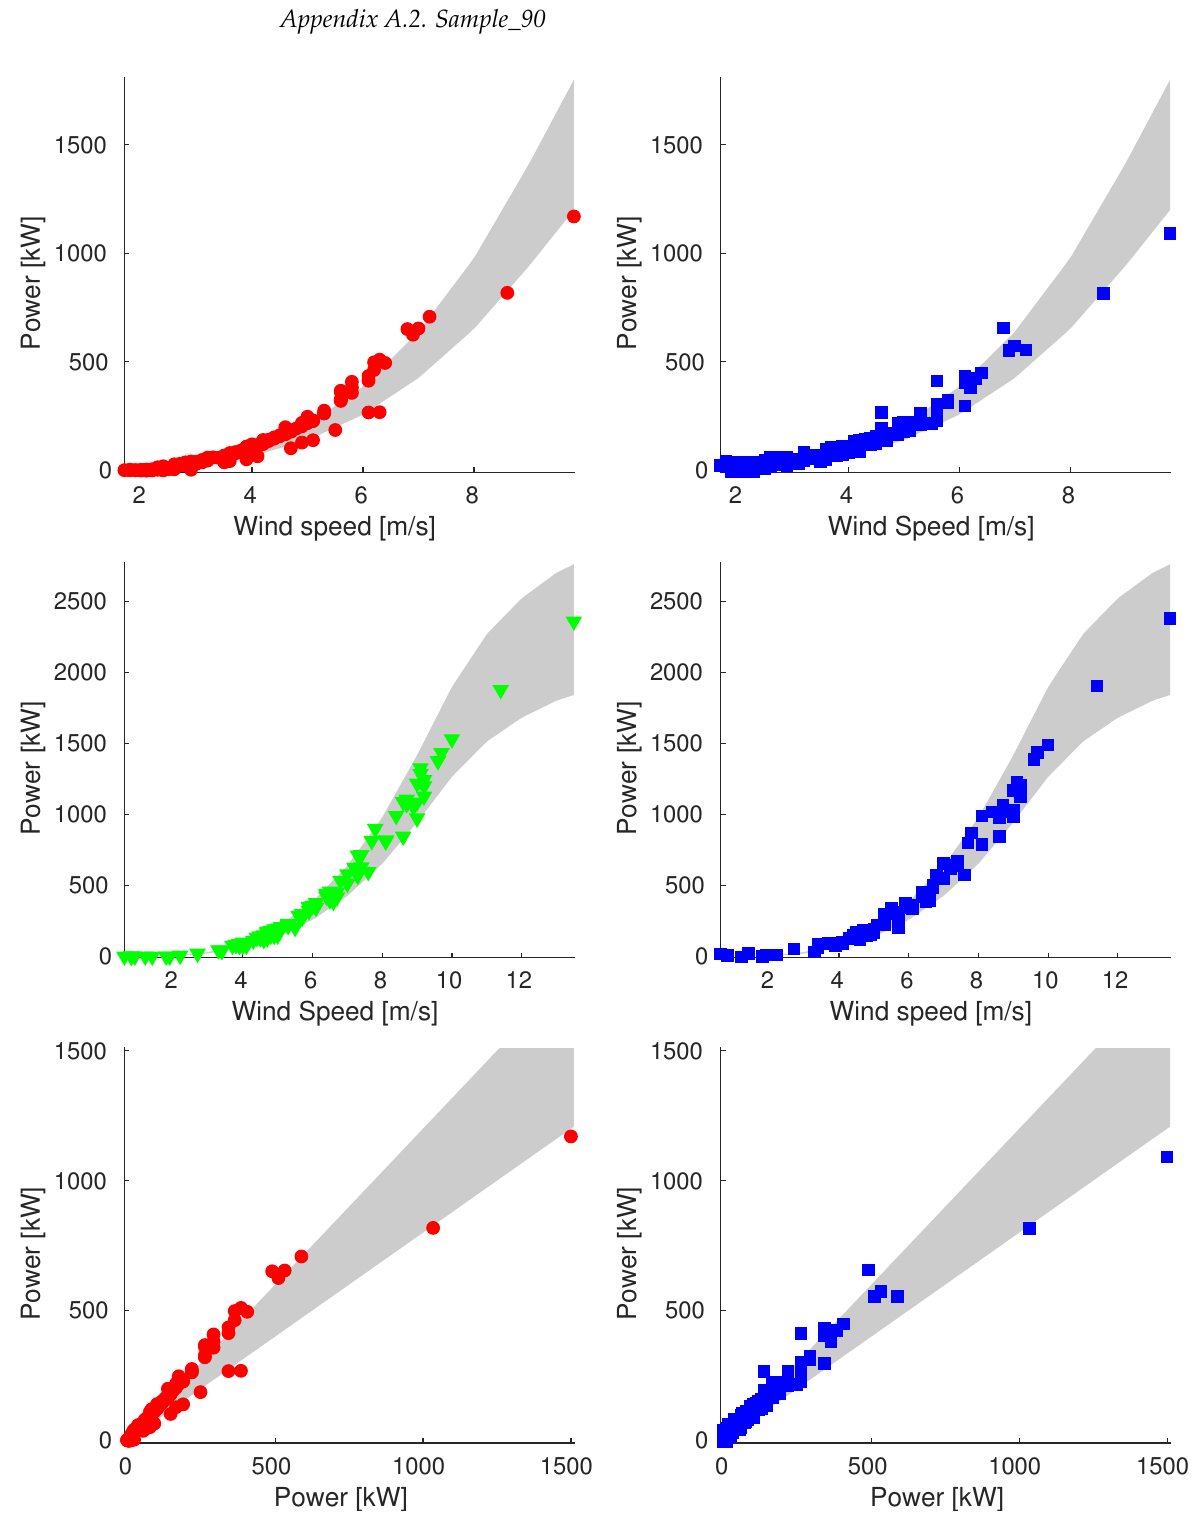
Figure A5. Plot of reconstructions for data points of 18 June ( Sample_90 ). We compare original data (on the left ) and reconstructed values (on the right ). We show plots of power vs.wind speed of rejected and validation data ( up and middle respectively) and plot of power vs.ideal power of rejected data ( bottom